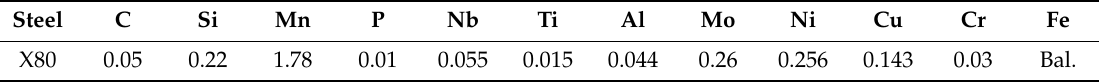
Table 1. Chemical composition of X80 steel used in this work